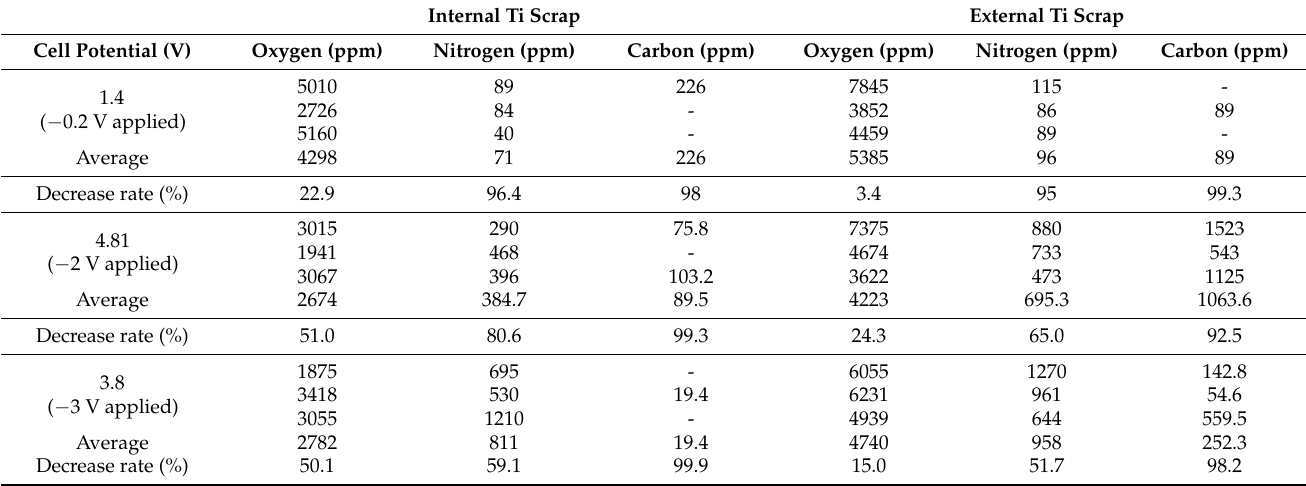
Table 1. Component analysis of Ti scrap after being subjected to deoxidation under various conditions. Internal Ti